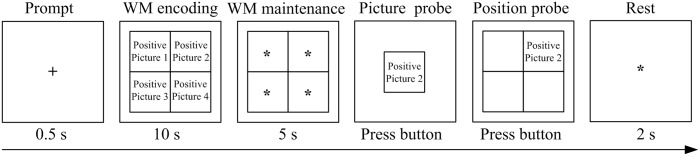
A schematic representation of an example trial of the working memory (WM) task in our experiment.Each trial included a symbol of “+” as a prompt (0.5 seconds); and a WM encoding task including the same emotional type of four pictures (10 seconds), followed by a WM maintenance task (5 seconds); and then a picture probe and a position probe to ask the subjects to judge by pressing the buttons, followed by a 2-second rest.